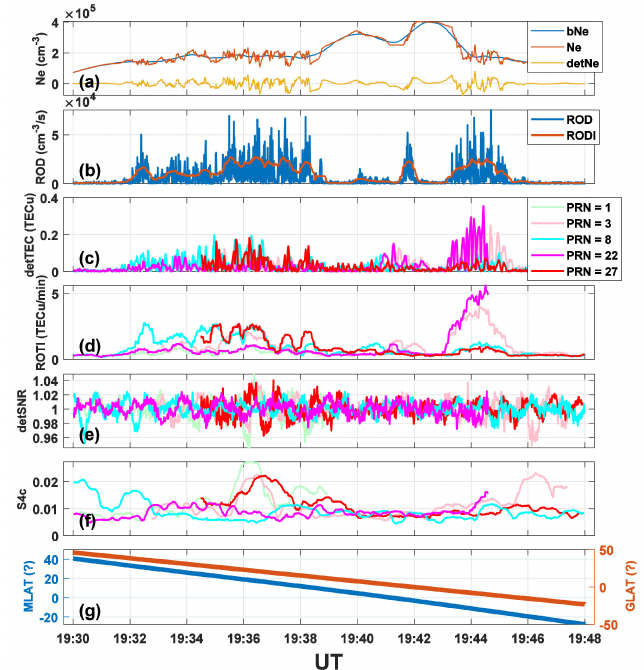
Figure 1. An example of the derived irregularity parameters from Swarm A as a function of UT on 21 December 2021. ( a ) electron density (Ne, red), background electron density (bNe, blue), and the detrended electron density (detNe, orange), ( b ) ROD and RODI, ( c ) detrended TEC, ( d ) ROTI, ( e ) detrended SNR, ( f ) S4c, ( g ) geomagnetic latitude and geographic